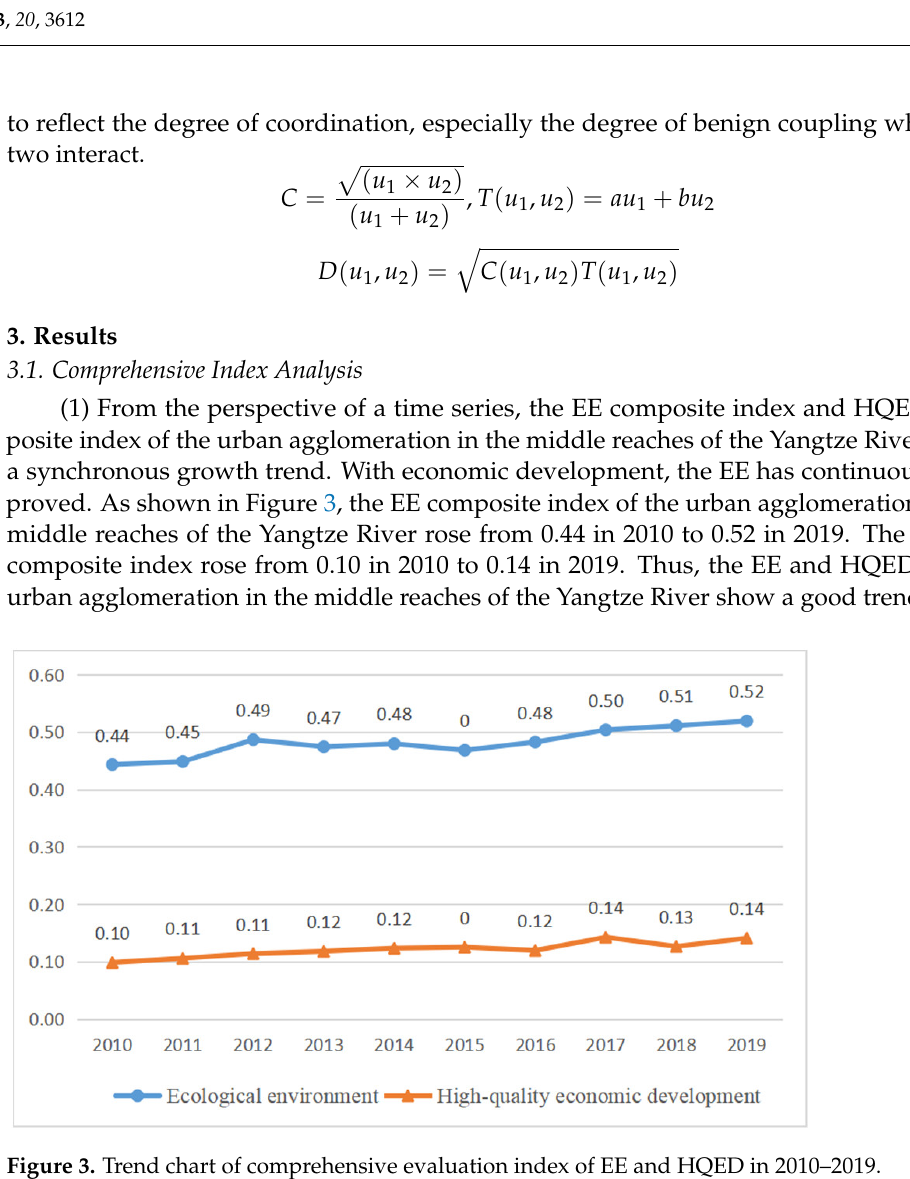
Figure 3. Trend chart of comprehensive evaluation index of EE and HQED in 2010–2019.